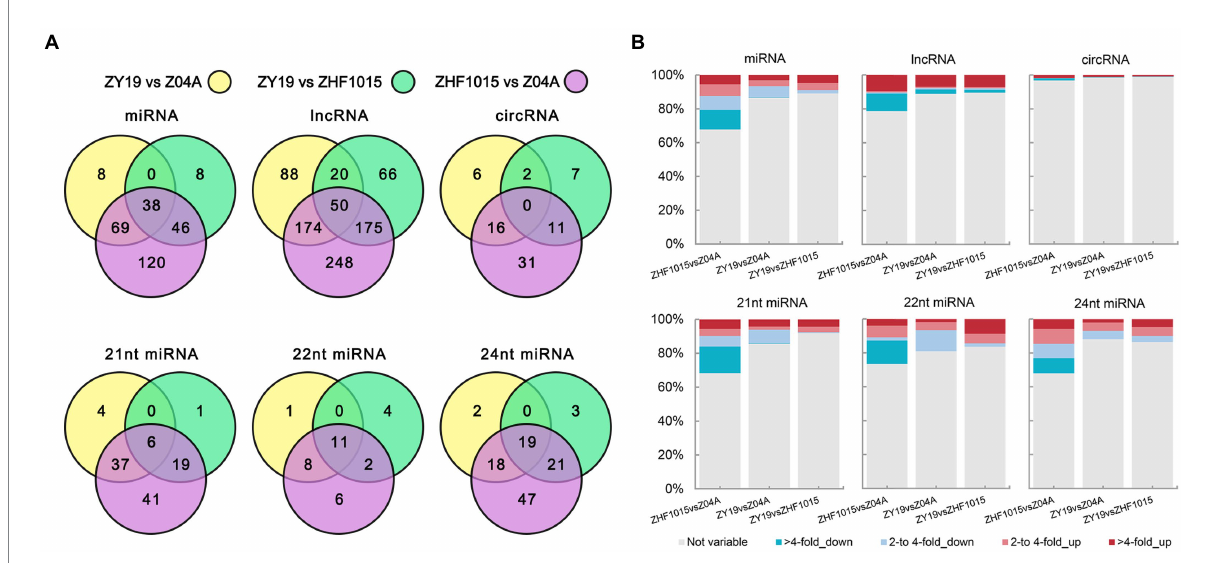
FIGURE 3 Differential expression ncRNAs between the three varieties. (A) Venn diagram of ncRNA of different difference groups. (B) Proportions of ncRNA with different levels of